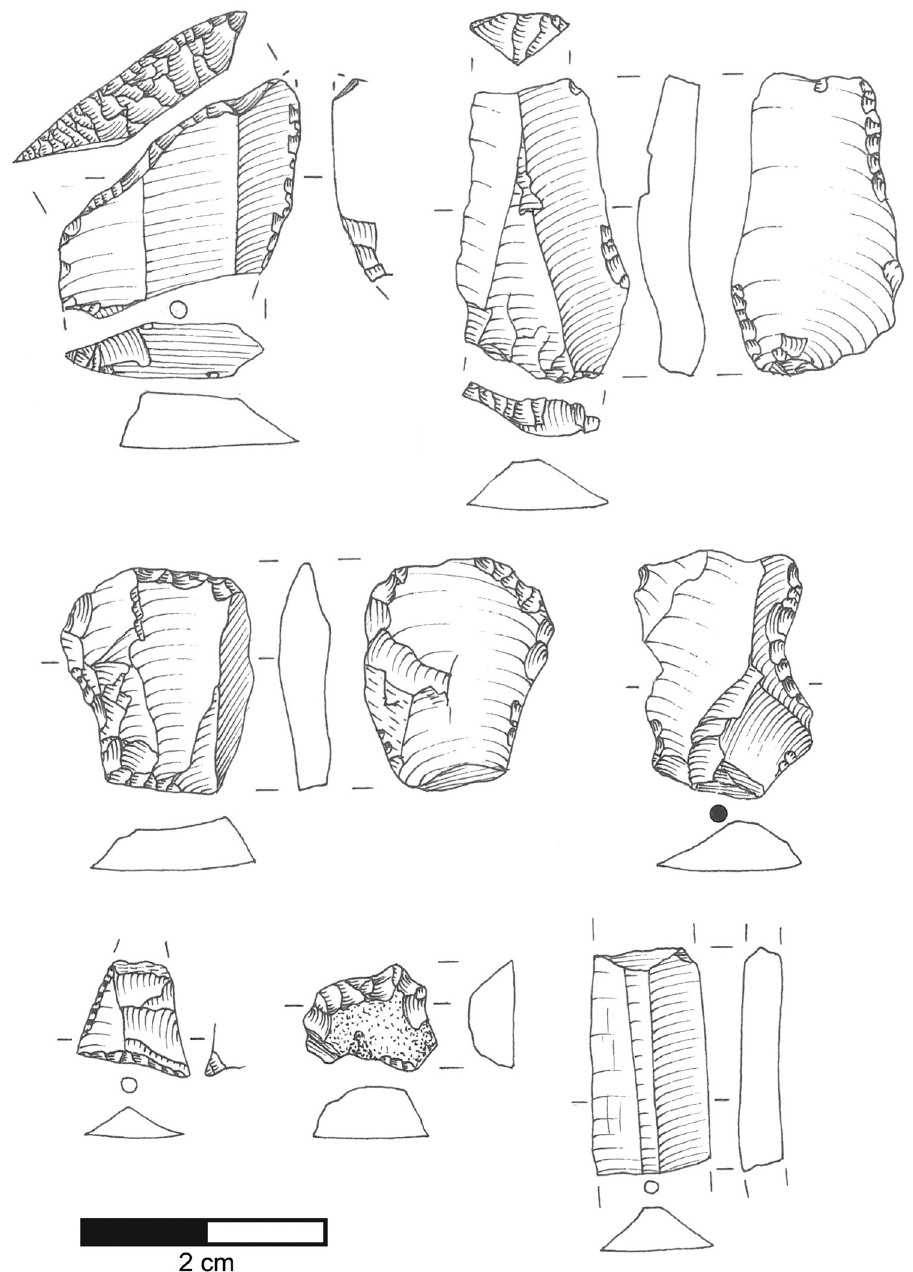
Figure 11: Microliths site cluster 4 . Drawings: B. Gehlen in Gulisano, 1995, Taf.3.4 –